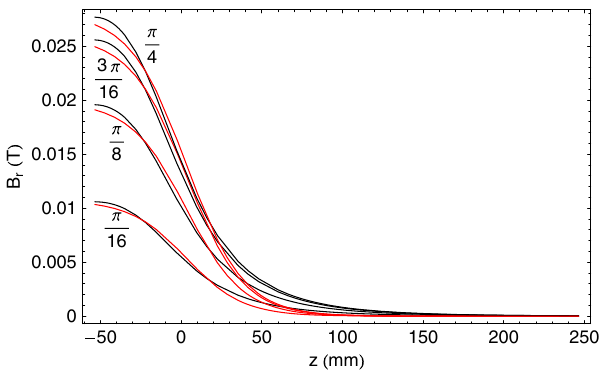
FIG. 12. Radial component of the magnetic field in an EMMA F quadrupole as a function of position along lines of fixed = 4 . Each pair of black and red lines shows the distance r ¼ r max field at a different value of the cylindrical polar coordinate θ , from π = 16 to π = 4 (in steps of π = 16 ). The black lines show the field obtained from the (numerical) magnetic model; the red lines show a symmetrized form of the analytical model (49) – (51), with fit = 10 , and parameters given in Table II with radius of fit r max b 2 ¼ 1 . 8 . The center of the quadrupole is at the far left of the plot, z ¼ − 53 . 6 mm.